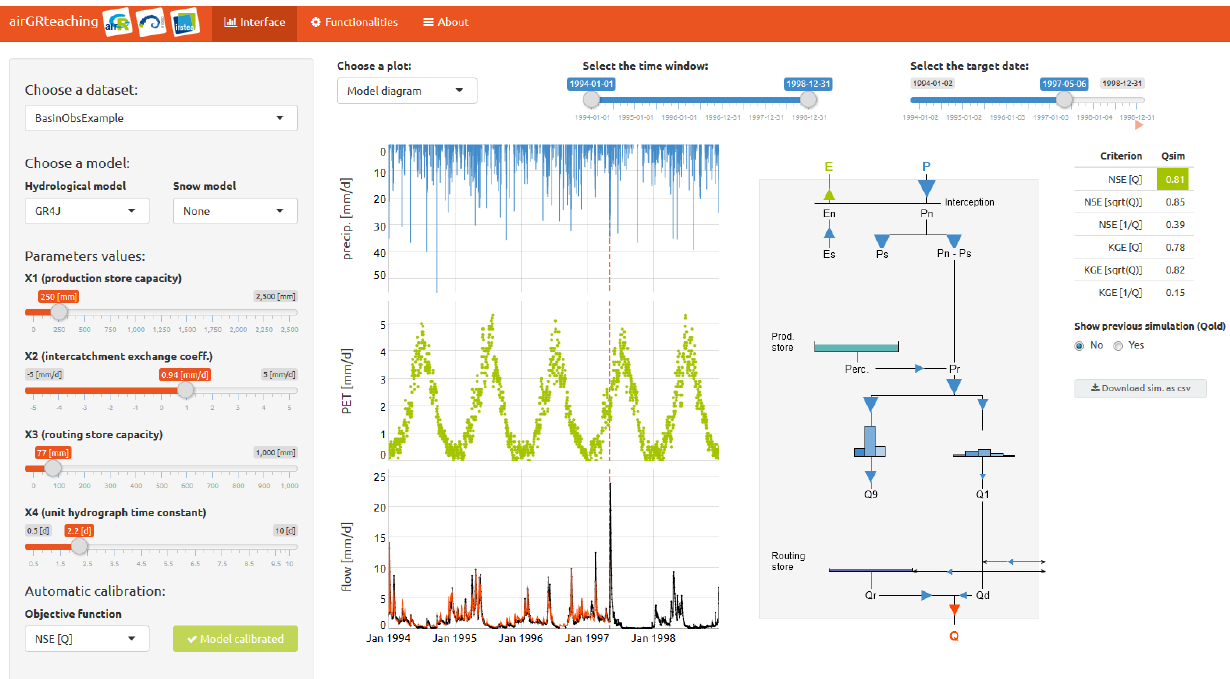
Figure 6. The airGRteaching interface that is used for teaching hydrological modelling. Students can choose a catchment dataset and a hydrological model and activate a snow model on the top left panel of the interface. Modifying the parameters values (on the left) by using the sliding bars will automatically update the graphs and scores displayed (on the right). This interface highlights in an interactive manner the basic principle of the rainfall–runoff relationship and its description in hydrological models. At the bottom left of the interface, an objective function can be chosen and an automatic calibration procedure can be launched within the